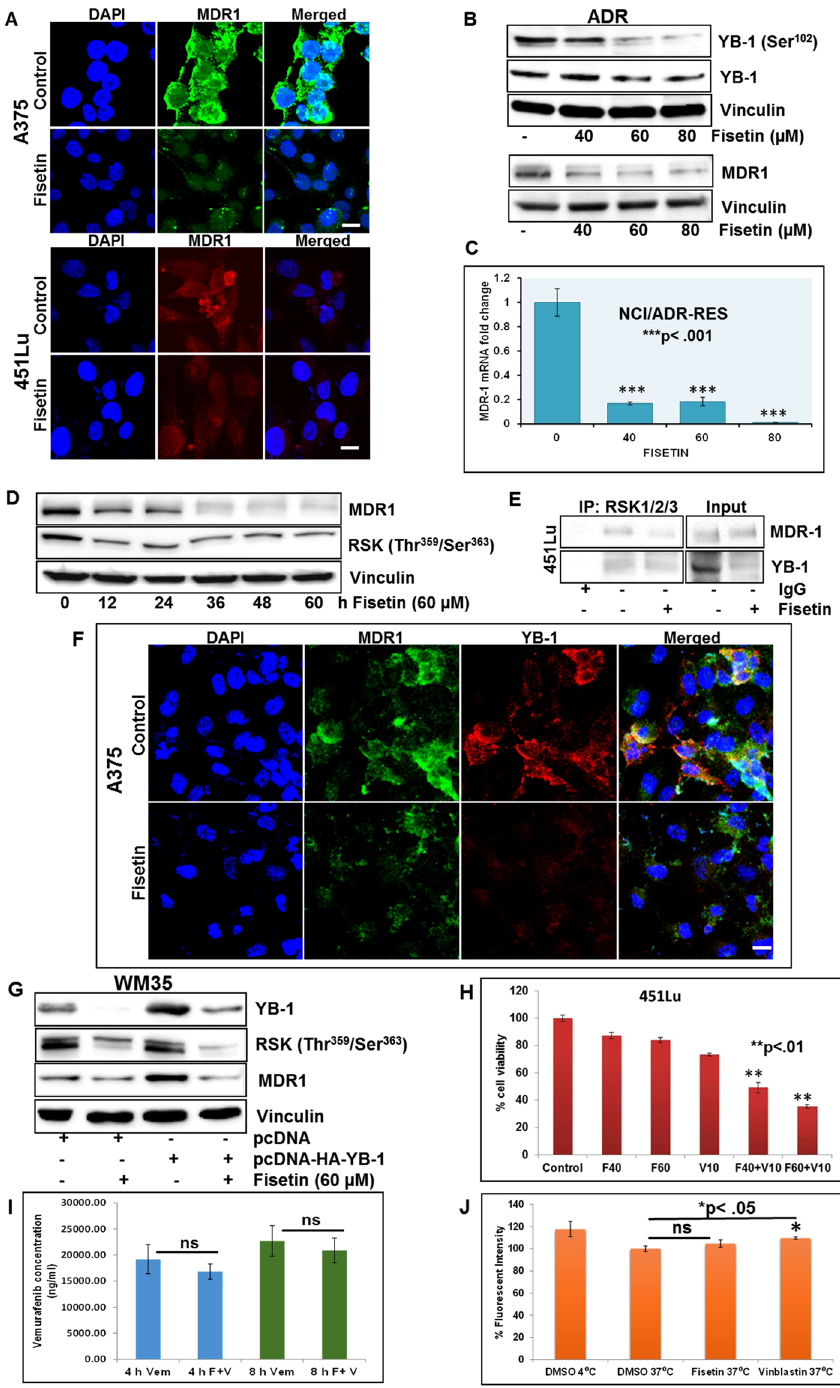
Figure 4. Fisetin induced modulation of YB-1/RSK signaling is associated with decrease in MDR1 ( A ) Representative images (20x) showing immunofluorescence for MDR1 in fisetin-treated A375 and 451Lu melanoma cells. Scale bar, 20 µ m. DAPI was used as nuclear staining control. ( B ) Whole cell lysates of NCI/ADR-Res ovarian cancer cells treated with fisetin (40–80 µ M:24 h) were analyzed for p-YB-1, YB-1 and MDR1 expression. Equal loading was confirmed by reprobing for vinculin. ( C ) Histogram represents relative MDR1 levels in NCI/ADR-Res cells treated with fisetin (40–80 µ M:24 h). Gene expression was measured by qPCR and normalized to GAPDH. Error bars represent mean ± SE among three independent experiments, where each experiment was performed in triplicate. ( D ) Analysis of MDR1 and p-RSK in fisetin-treated A375 cells at specified time points. Equal loading was confirmed by reprobing for vinculin. ( E ) Equal amounts of cell lysates treated with/without fisetin (60 μ M:24 h) were immunoprecipitated with RSK antibody followed by western blot analysis for MDR1 and YB-1 antibodies. ( F ) Representative images (20x) showing immunofluorescence for MDR1 (green) and YB-1 (red) in fisetin-treated (60 µ M:24 h)